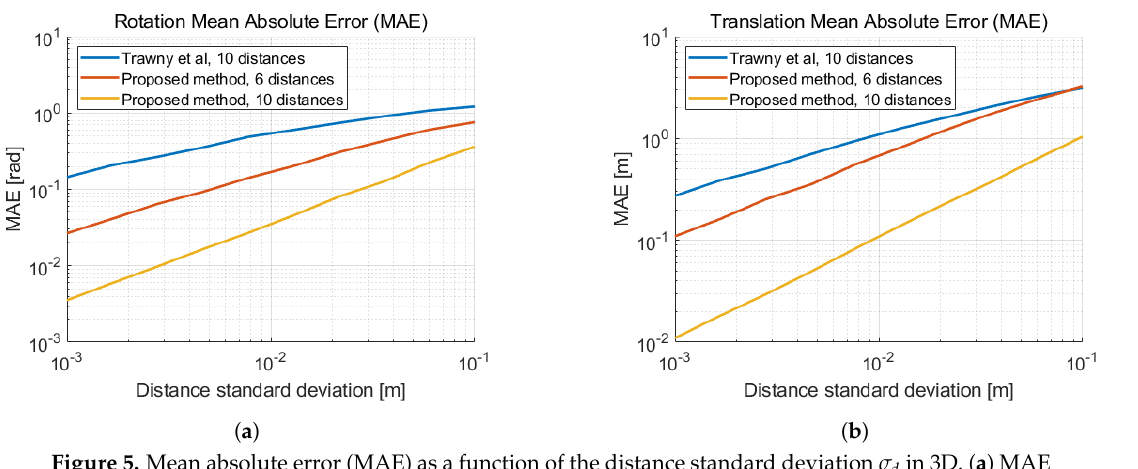
Figure 5. Mean absolute error (MAE) as a function of the distance standard deviation σ d in 3D. ( a ) MAE of the yaw rotation with respect to the ground truth. ( b ) MAE of the translation with respect to the ground